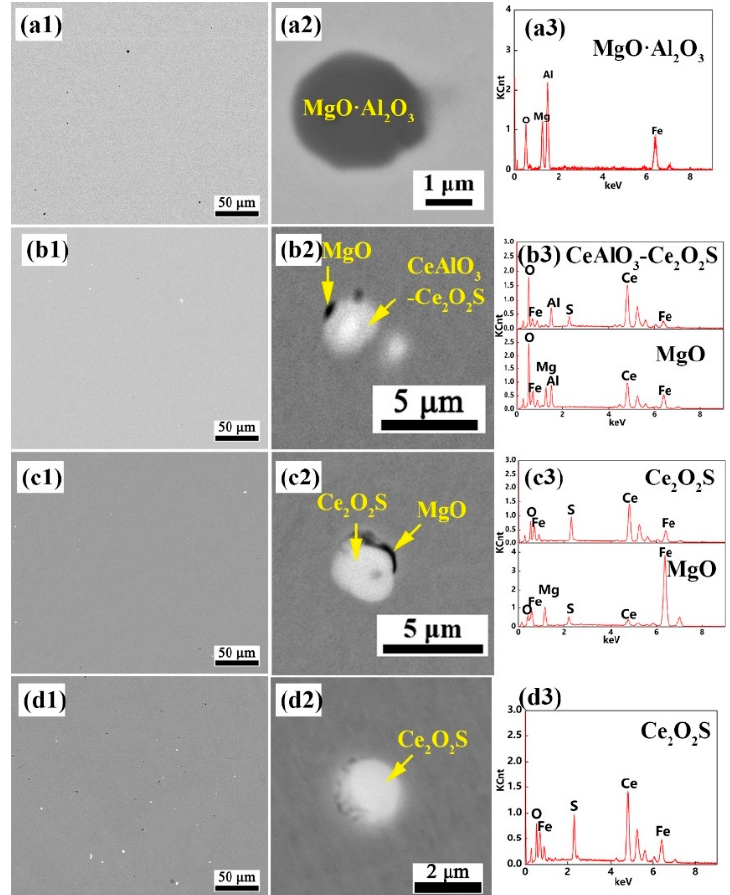
Figure 5. Typical inclusions in the melts. ( a1 – a3 ) B-1 (Ce-free); ( b1 – b3 ) B-2 (0.014% Ce); ( c1 – c3 ) B-3 (0.024% Ce) and ( d1 – d3 ) B-4 (0.037% Ce).